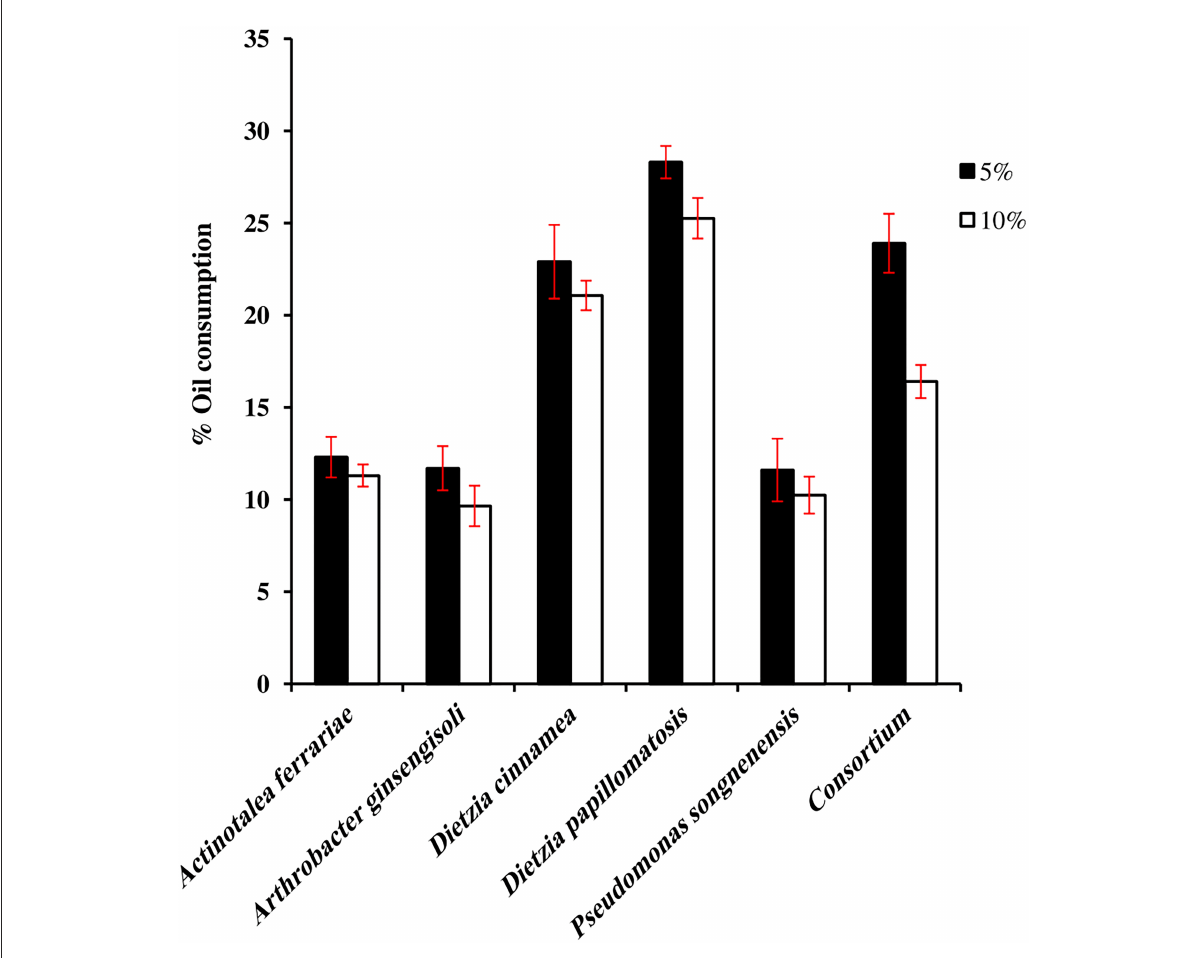
FIGURE1 Oil consumption by individual hydrocarbonoclastic bacteria and consortium.